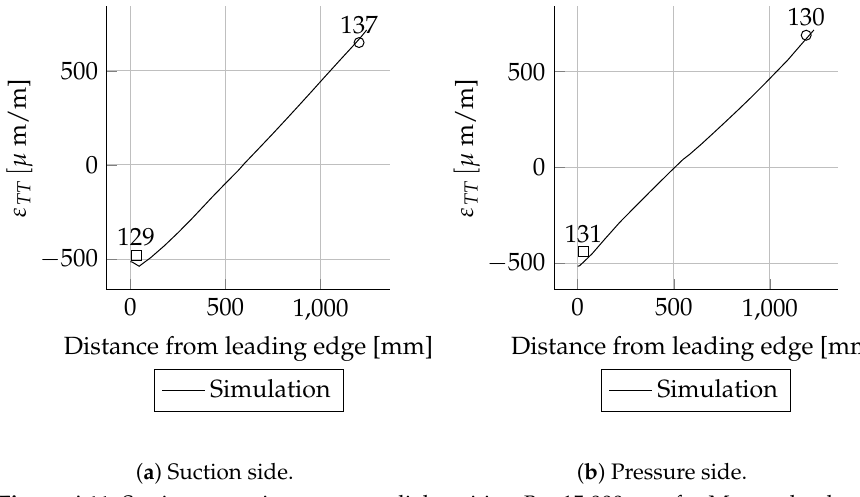
Figure A11. Strain comparison ε LL at radial position R = 15,000 mm for Mxmax load